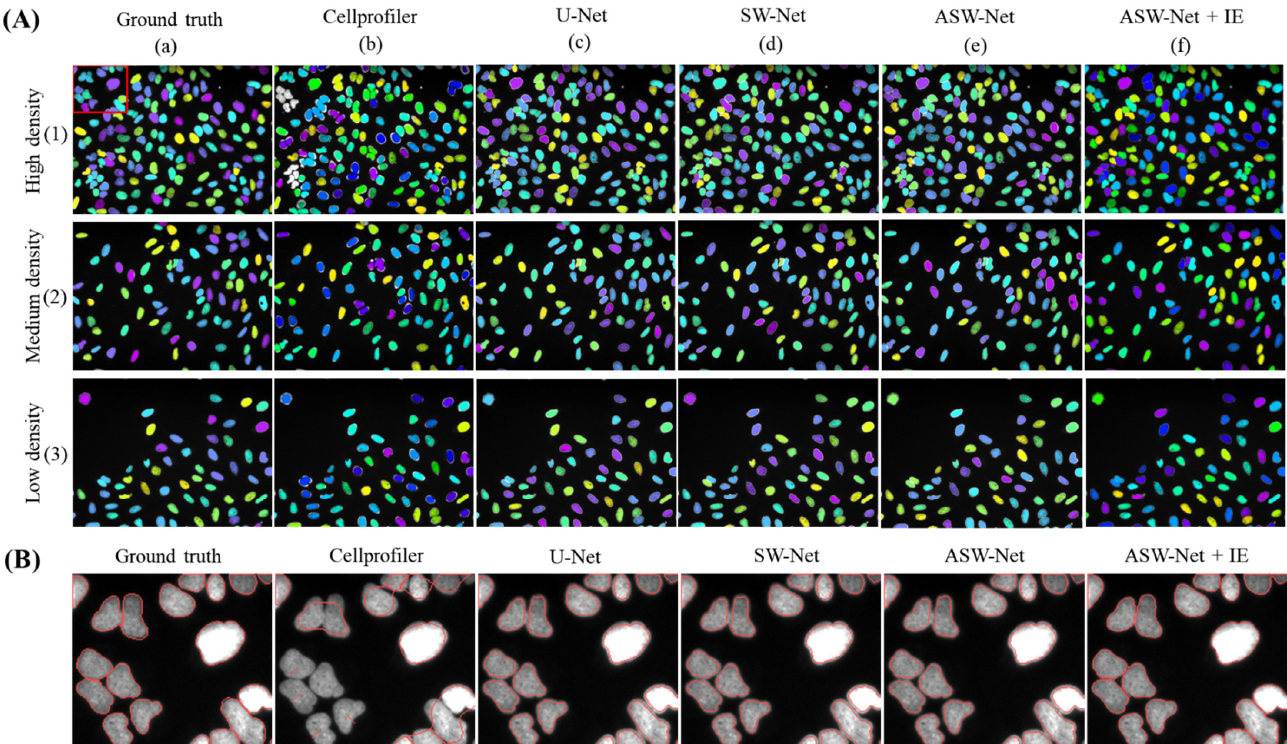
Figure 3. Visualized comparison between ASW-Net and other existing methods against the ground truth. ( A ) Three images with different nuclear distribution densities were randomly selected for this study. From top to bottom are high density, medium density, low density of nuclear images, respectively. From left to right are the masks of ground truth, the prediction of Cellprofiler, U-Net, SW-Net, ASW-Net, ASW-Net plus interior expansion, respectively. The nuclear masks are colored randomly. ( B ) Magnified segmentation result and the ground truth. From left to right are the mask outlines of ground truth, the prediction of Cellprofiler, U-Net, SW-Net, ASW-Net, ASW-Net plus interior expansion, respectively.